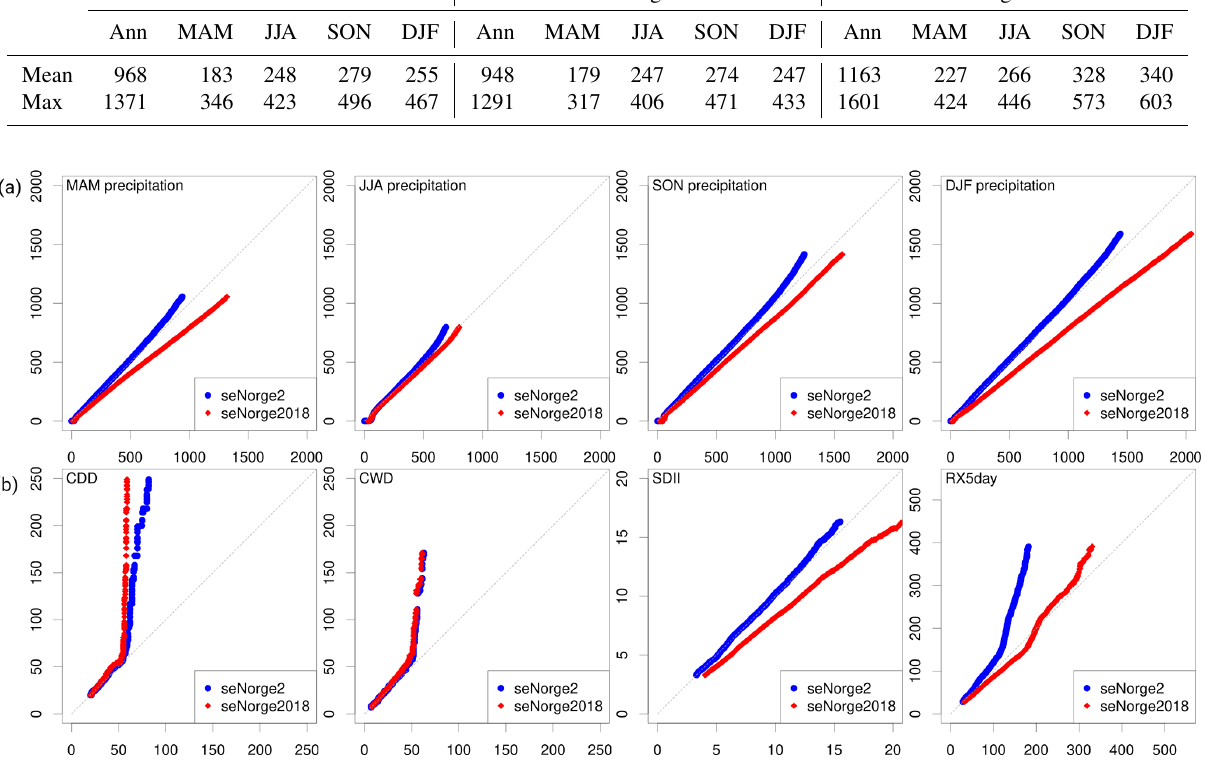
Figure 11. Quantile plot of (a) seasonal precipitation, where each point represents the sum of a grid value over 3 months and (b) ex- treme value indices (ETCCDI) values, but these correspond to the maximum of the entire time series. Each plot shows seNorge2 ( • ) and seNorge2018 ( (cid:7) ) values on the x axis and EMO-5 values on the y axis in mm. For a better visual overview, the highest 0.01% of the data have not been